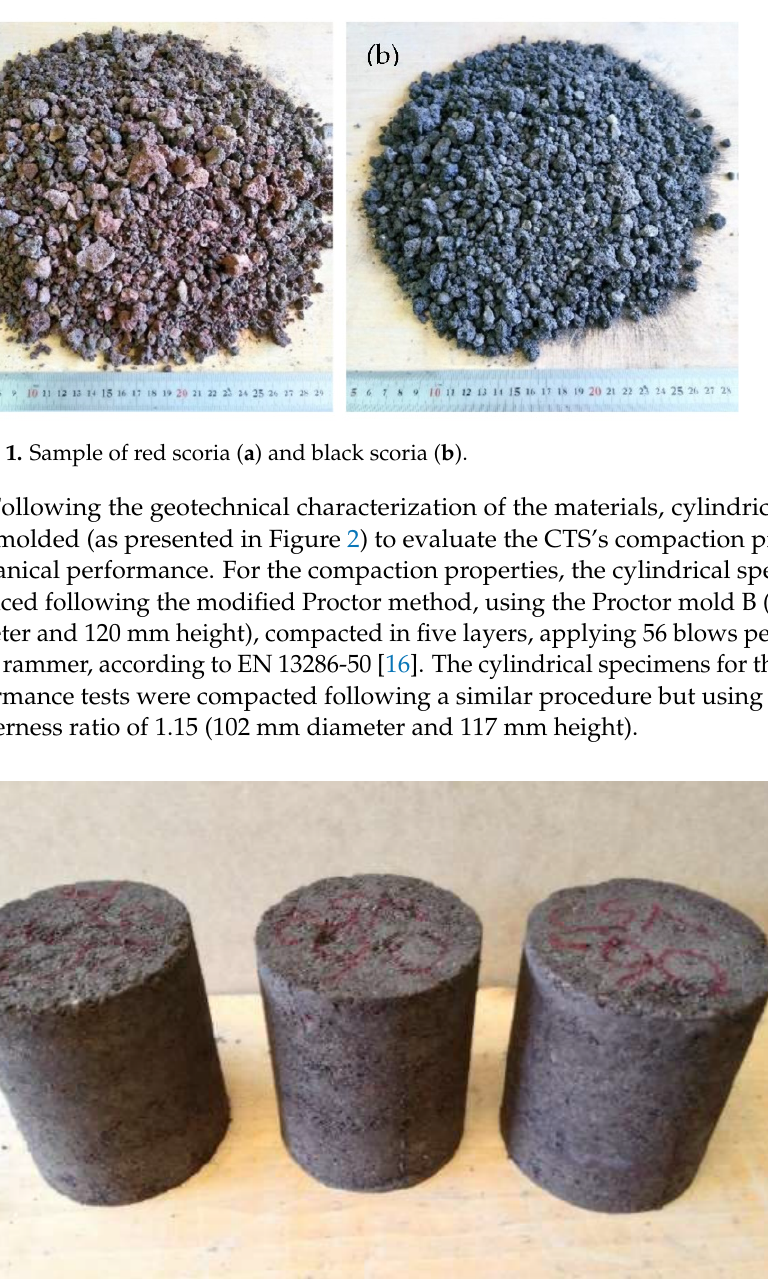
Figure 2. Example of three compacted specimens of CTS.